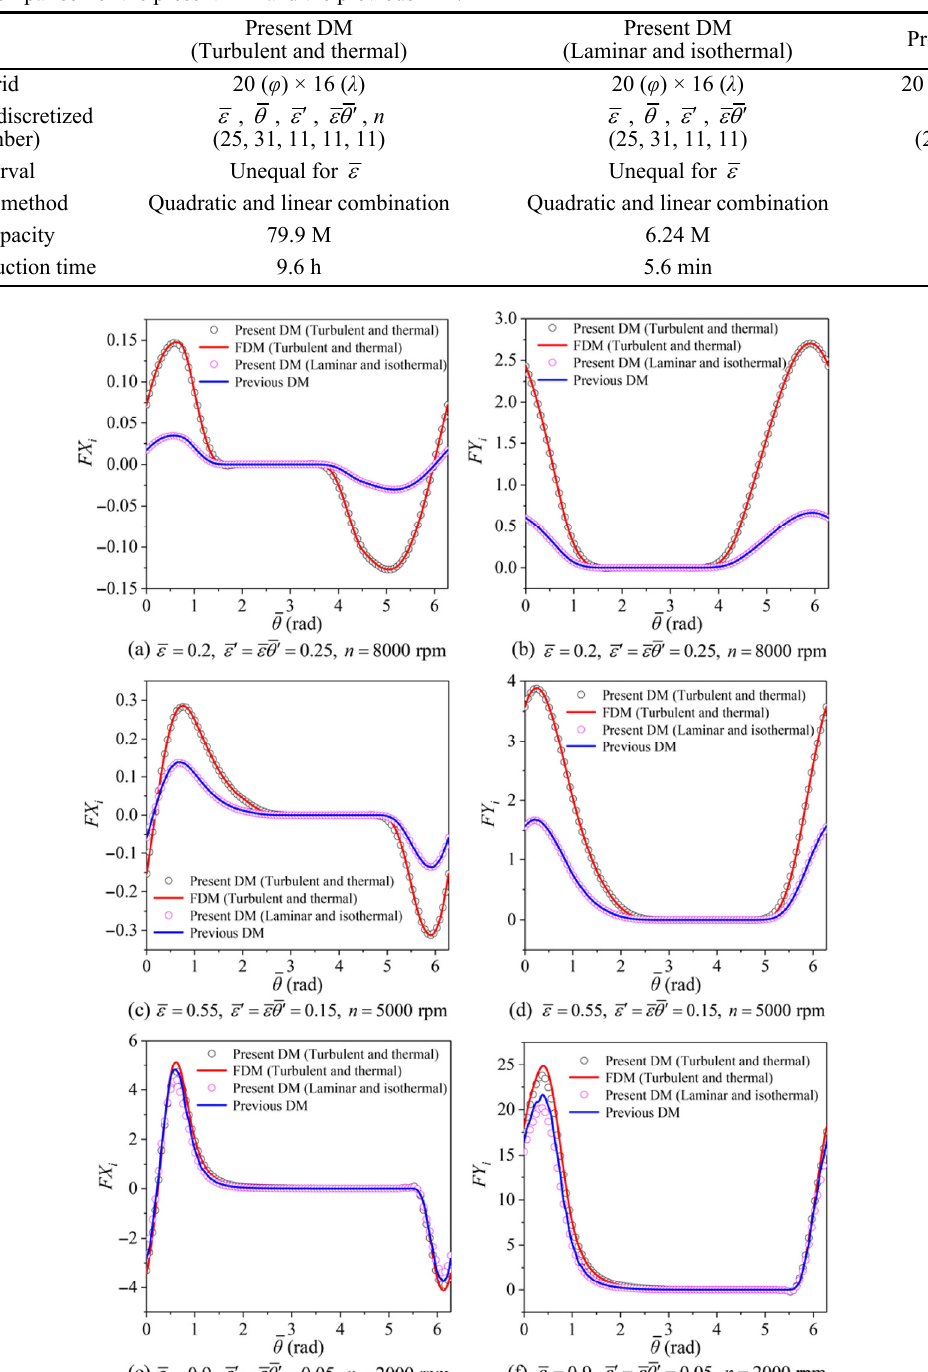
Fig. 5 Present DM, FDM, and previous DM solutions for the dimensionless NFFF as a function of 